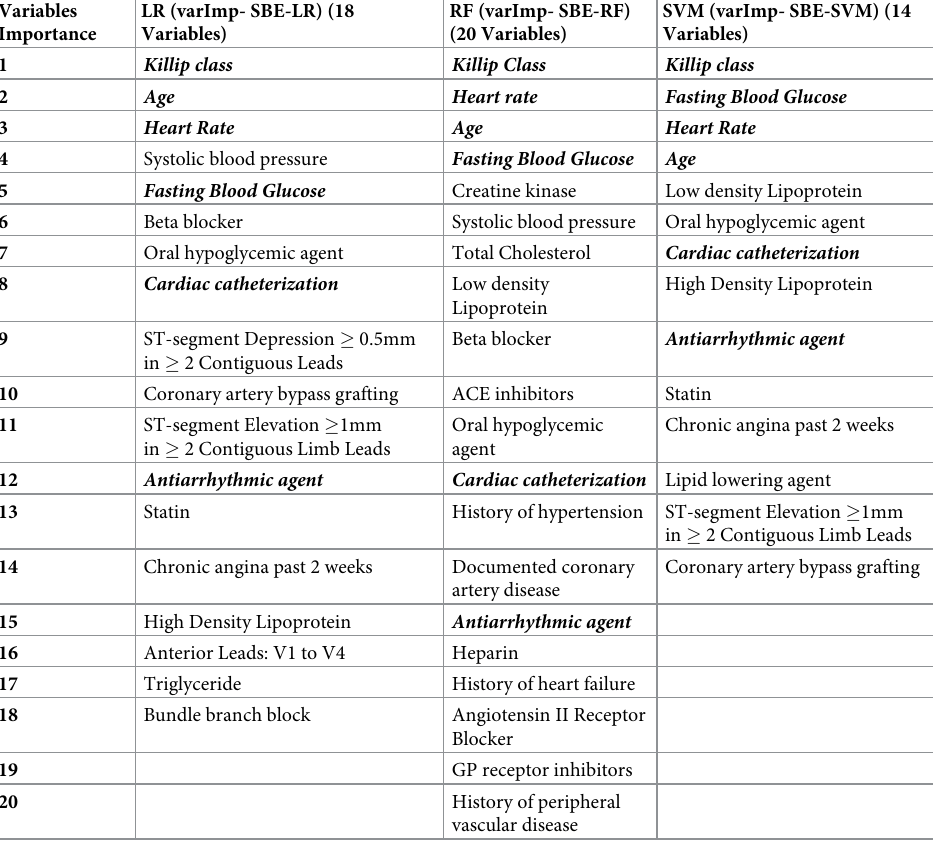
� Variables in Blue: Predictors in common among all the 3 models after features selection.